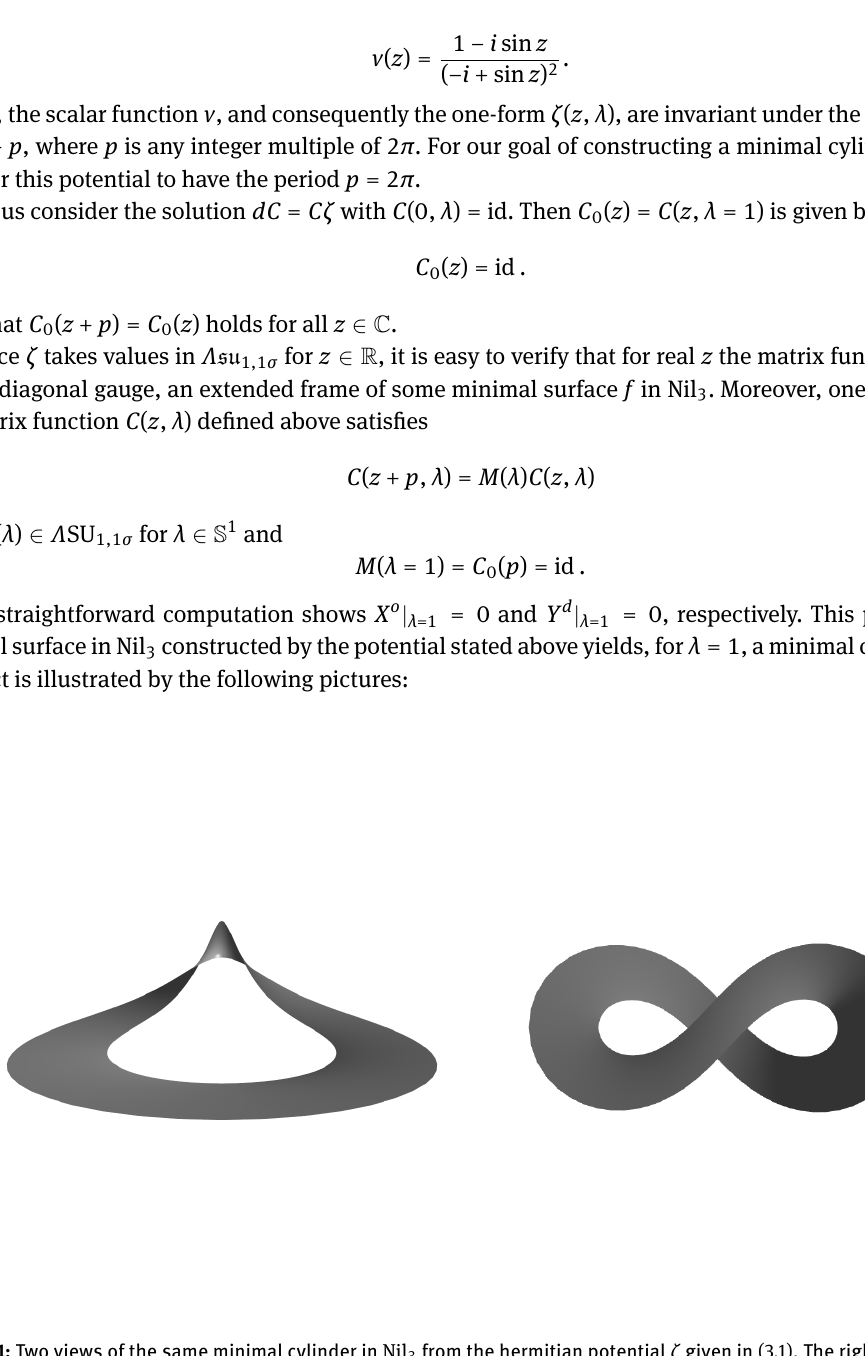
Figure 3.1: Two views of the same minimal cylinder in Nil 3 from the hermitian potential ζ given in (3.1) . The right-hand side